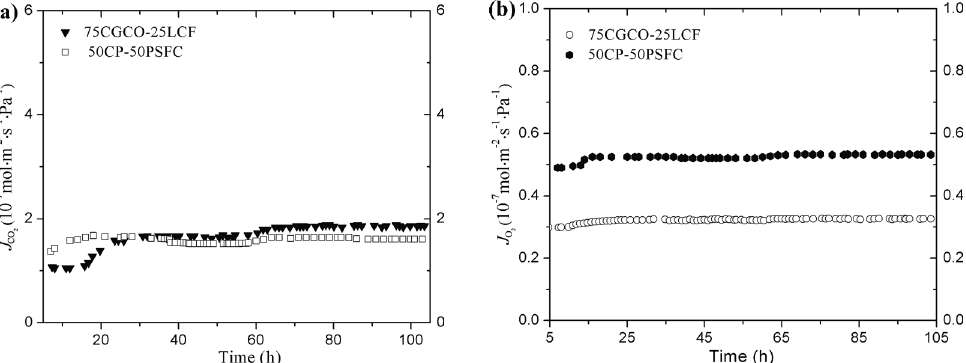
Fig. 10 Long-term permeation stability test performed at 875 ℃ using 85%air/15%CO 2 as feed gas and argon as sweep gas: (a) J CO and (b) J O for the 100 h 2 2